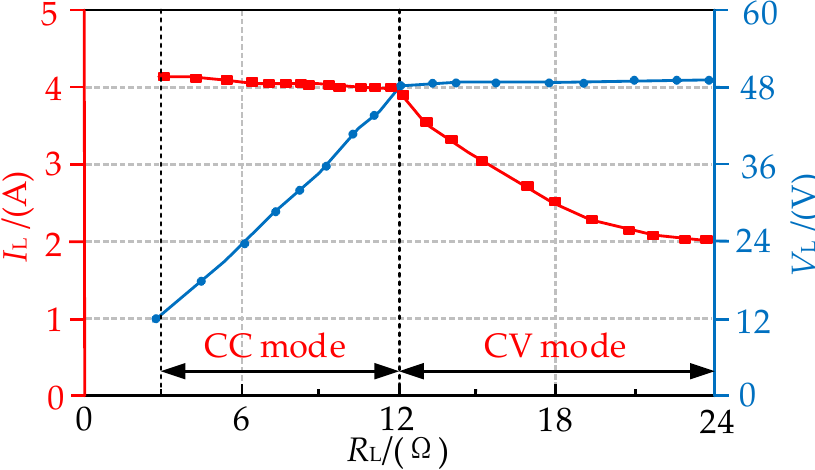
Figure 22. Measured output characteristics versus the load. As shown in Table 3, the performance of the work in this paper is compared with other existing single-switch circuit based WPT. It can be seen that the proposed topology with the composite shielding structure can achieve higher